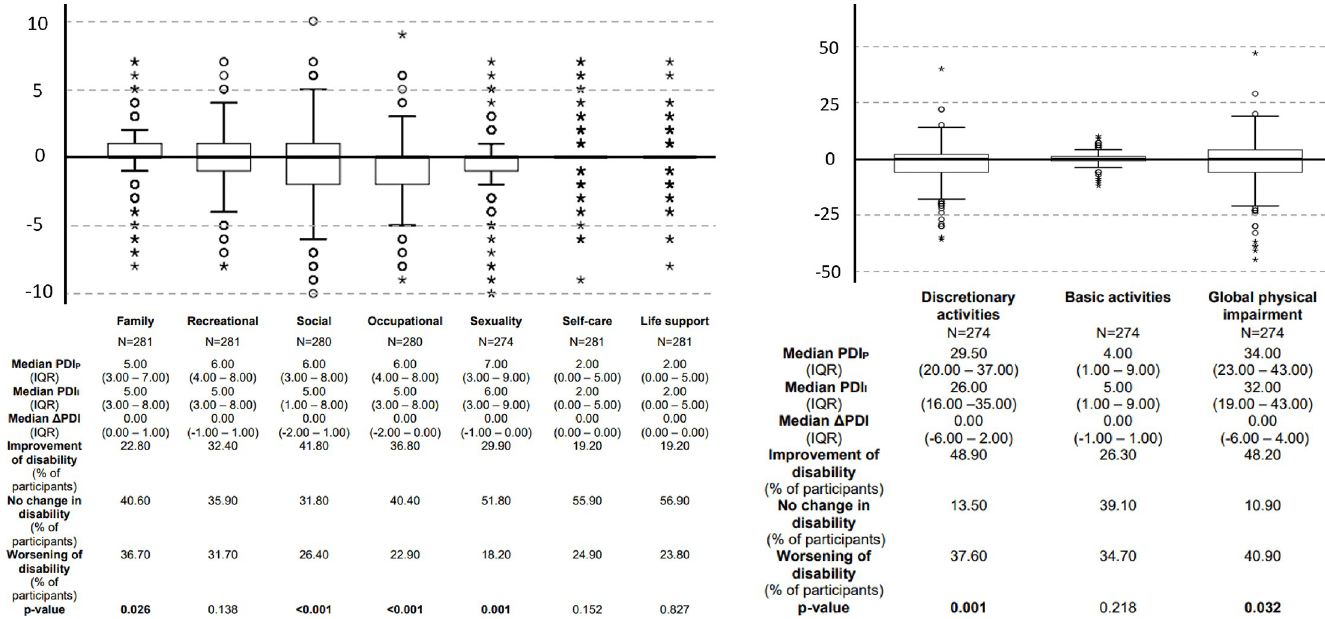
Fig 2. Differences of pain disability index ( Δ PDI) during social isolation or quarantine (PDI I ) and previous to social isolation or quarantine (PDI P ). (A) Boxplots of the difference of pain disability index during social isolation or quarantine (PDI I ) and previous to social isolation or quarantine (PDI P ) are displayed in all assessed areas of life (“family”, “recreational”, “social”, “occupational”, “sexuality”, “self-care” and “life support”). (B) Boxplots of the difference of pain disability index during social isolation or quarantine (PDI I ) and previous to social isolation or quarantine (PDI P ) are displayed in the sum scores discretional activities (sum score of: “family”, “recreational”, “social”, “occupational” and “sexuality”), the sum score basic activities (sum score of: “self-care” and “life support”), and the global physical impairment as the sum score of all assessed areas of daily life. Positive values mean increased pain disability during social isolation or quarantine. Negative values mean decreased pain disability during social isolation or quarantine. The value 0 means no changes in pain disability. Data are presented as median values (IQR) and percentage of respondents who experienced decreased, increased or no change in pain induced disability. N represents the number of women who answered the questions about pain disability regarding both time periods: Previous and after isolation or quarantine. Values in bold indicate statistical significance (Wilcoxon test), as the level of statistical significance was set to p � 0.05.